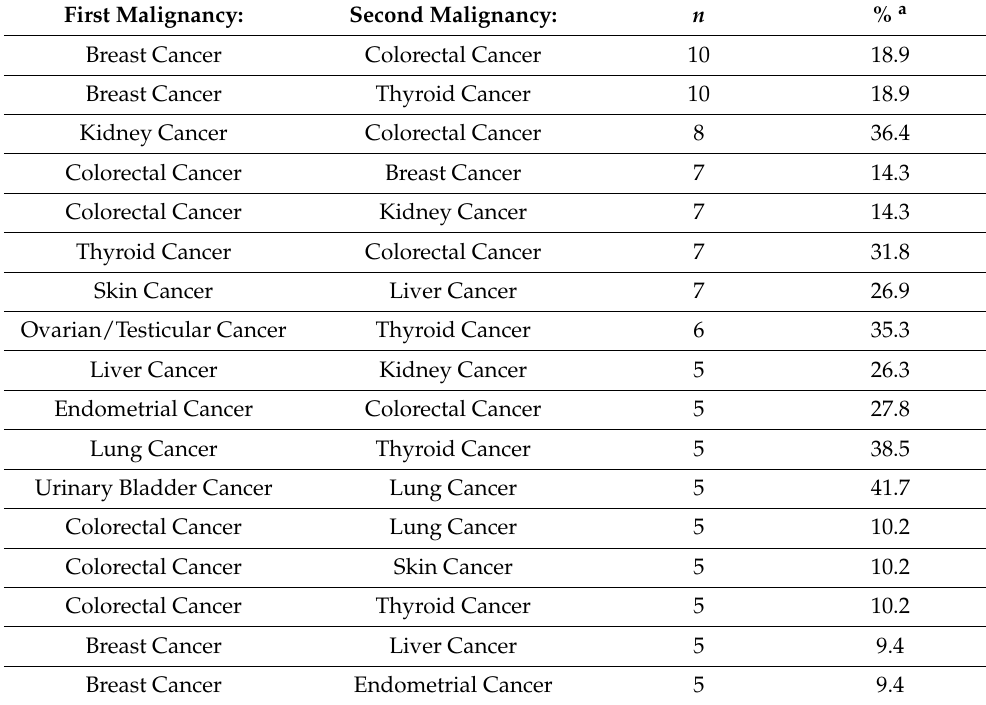
Table 3. The Most Frequent Malignancy